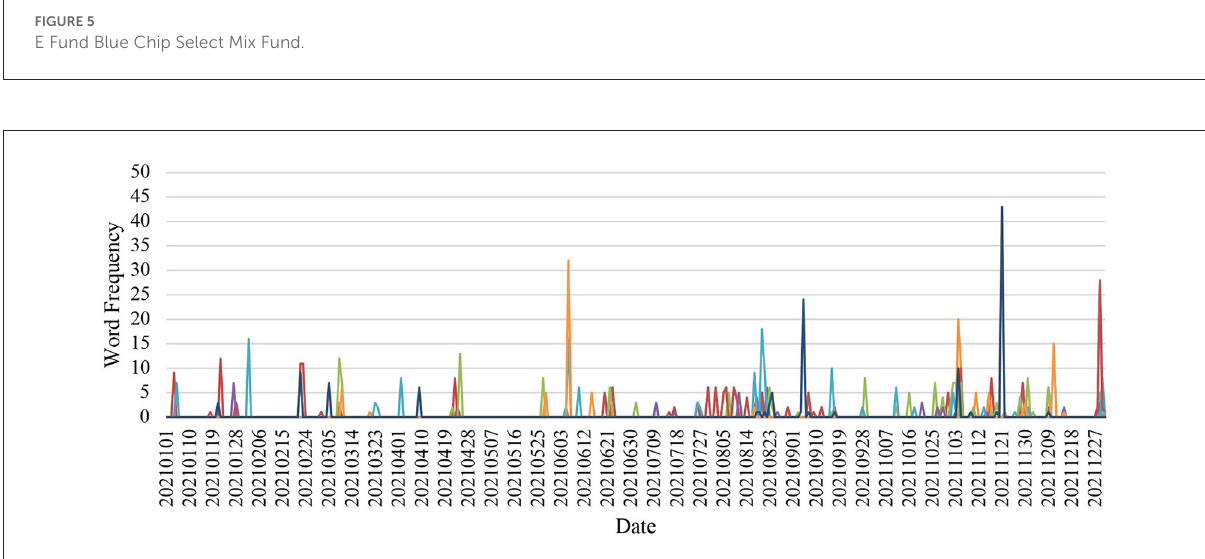
FIGURE6 Merchants Liquor Index